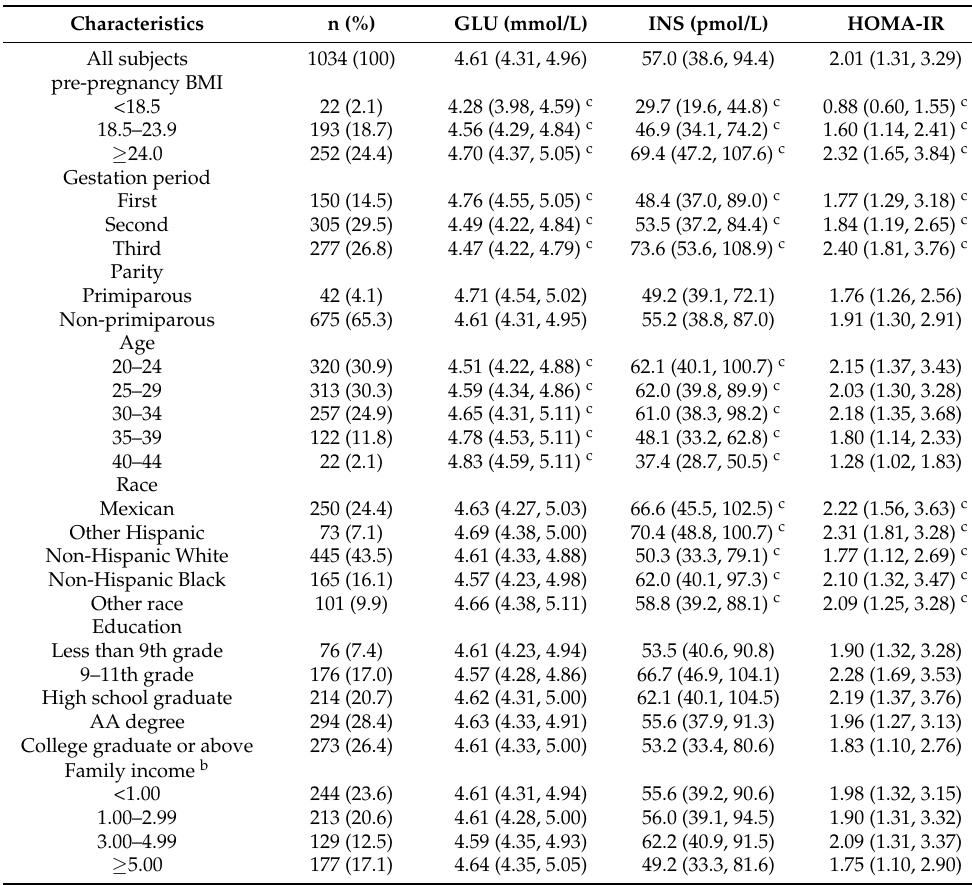
Table 2. Characteristics of study population a